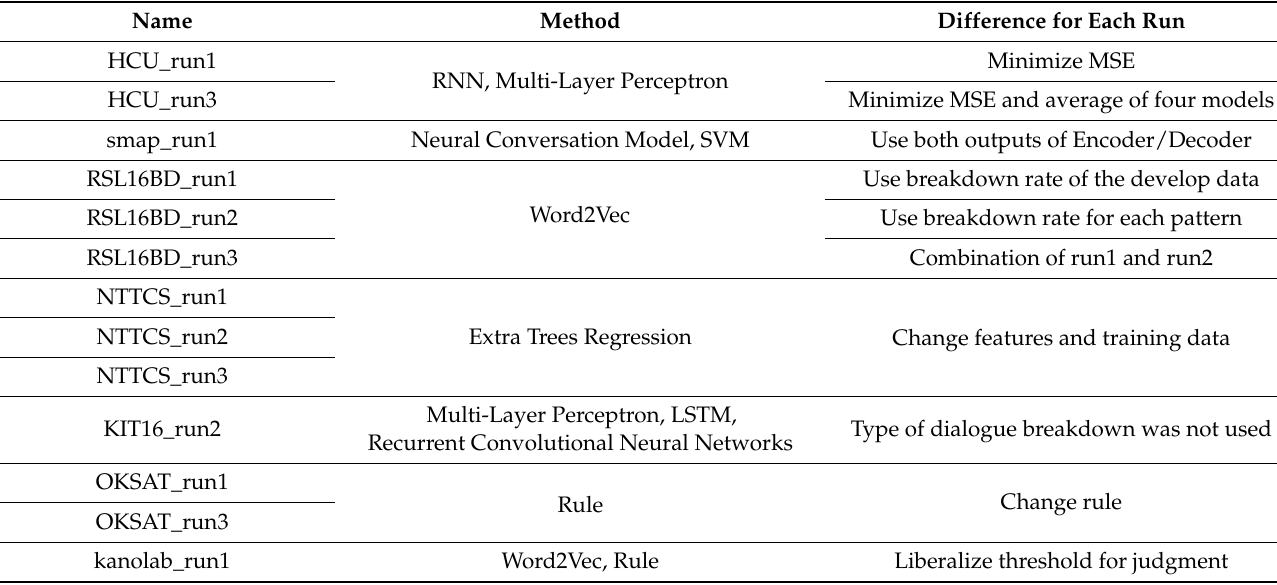
Table 16. List of the other detection methods for the comparison.